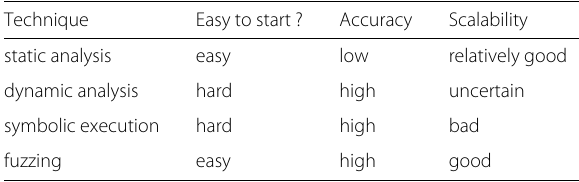
Table 1 Comparison of different techniques